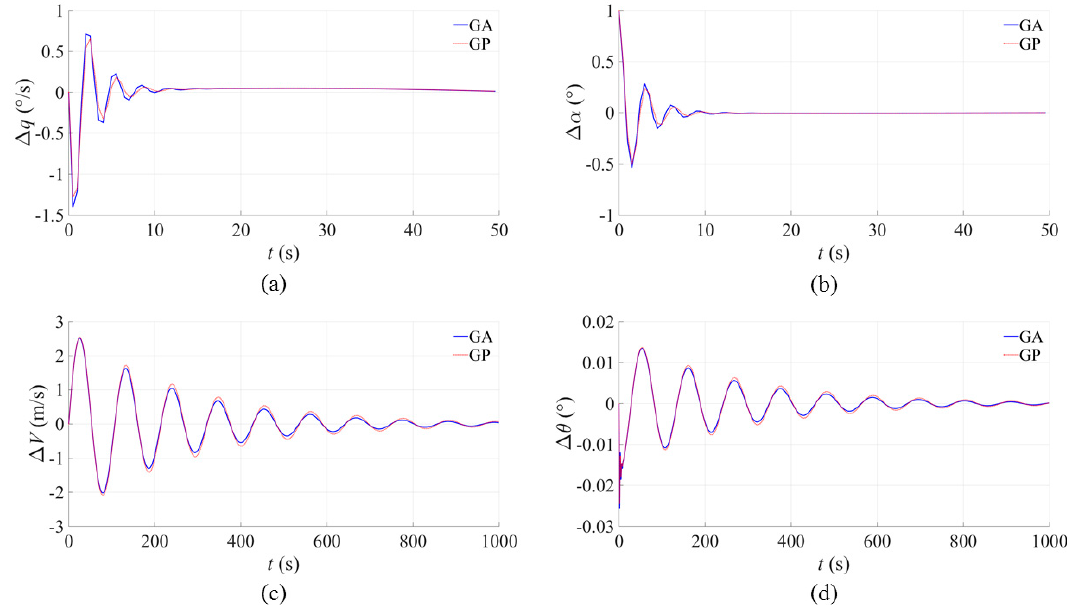
Figure 10. Characteristic transient: ( a ) perturbation pitch rate; ( b ) perturbation angle of attack; ( c ) ( c ) perturbation velocity; ( d ) perturbation pitch perturbation velocity; ( d ) perturbation pitch angle.